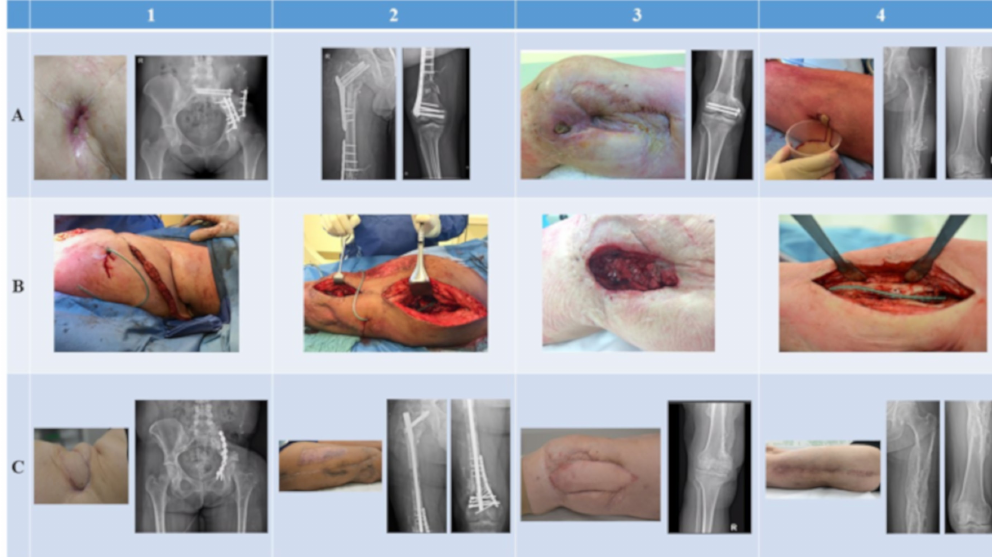
Figure 2. Clinical and radiological images of all patients treated with phage therapy. Each column represents a patient. Rows represent the preoperative ( A ), intraoperative ( B ), and postoperative ( C ) status of each